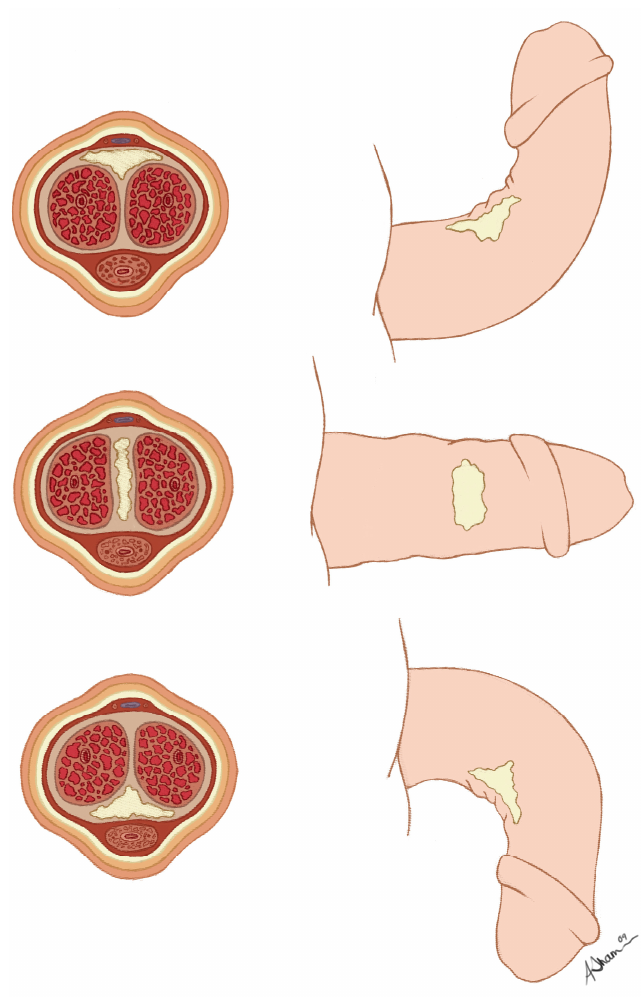
FIGURE 1. Locations of PD plaque. Dorsal midline plaque results in an upward curvature, whereas ventral midline plaque results in a downward curvature. Dorsal and ventral plaques may connect through septal extensions to form an I-beam, causing penile shortening without